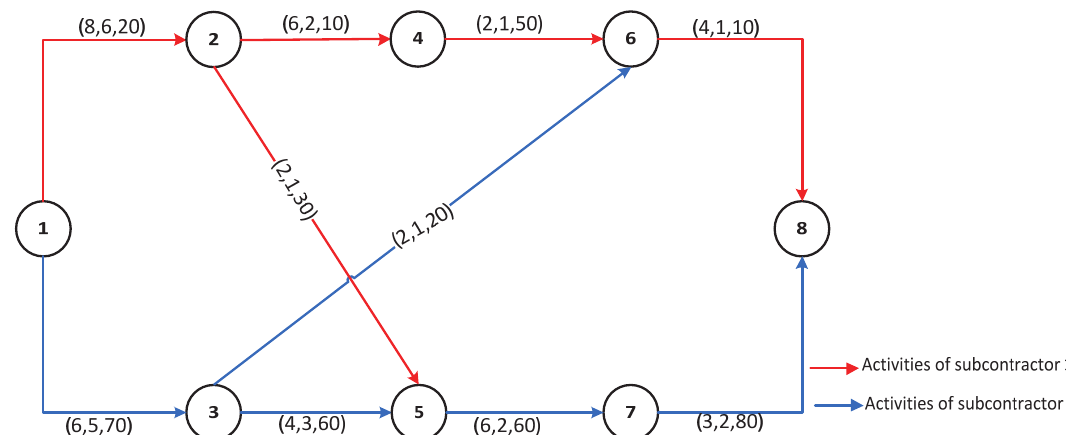
Fig. 6. AoA network for two subcontractors with interaction